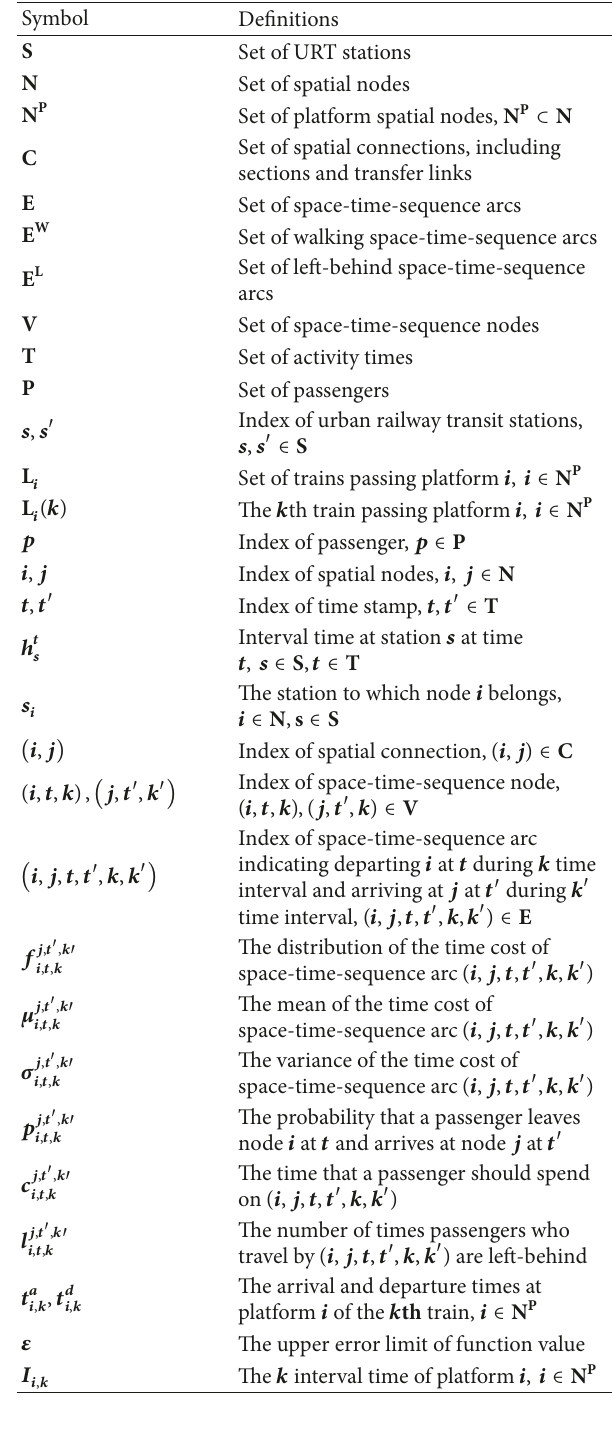
Table 1: Notations and input